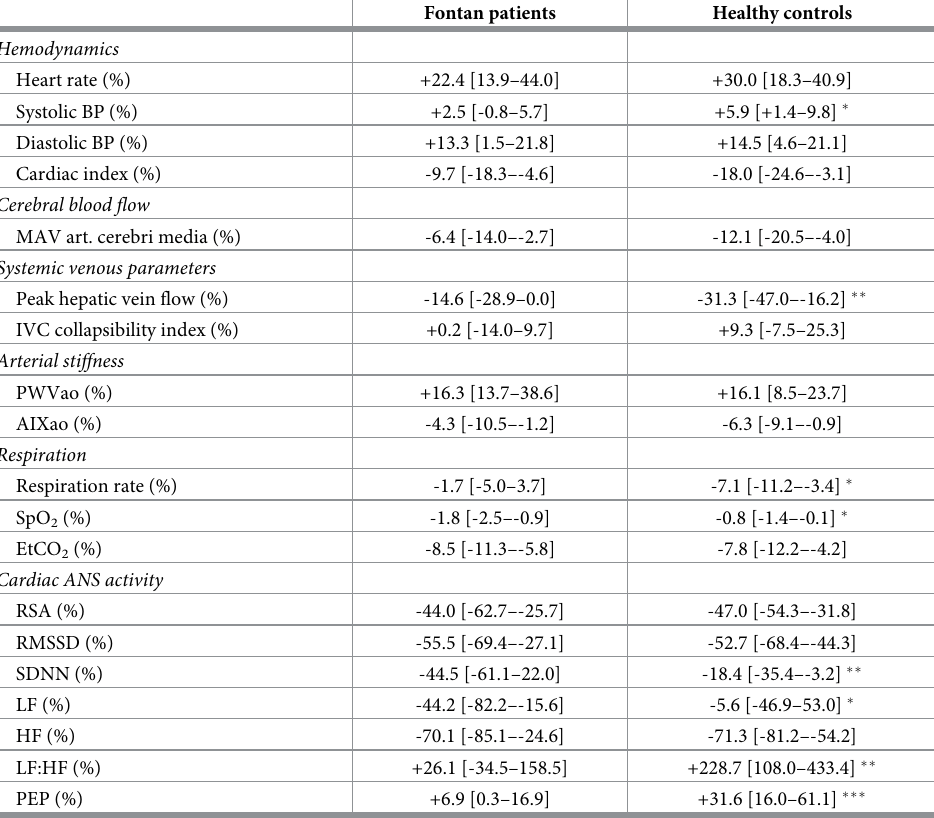
Table 3. Percentage change of parameters during head-up tilt in Fontan patients and healthy